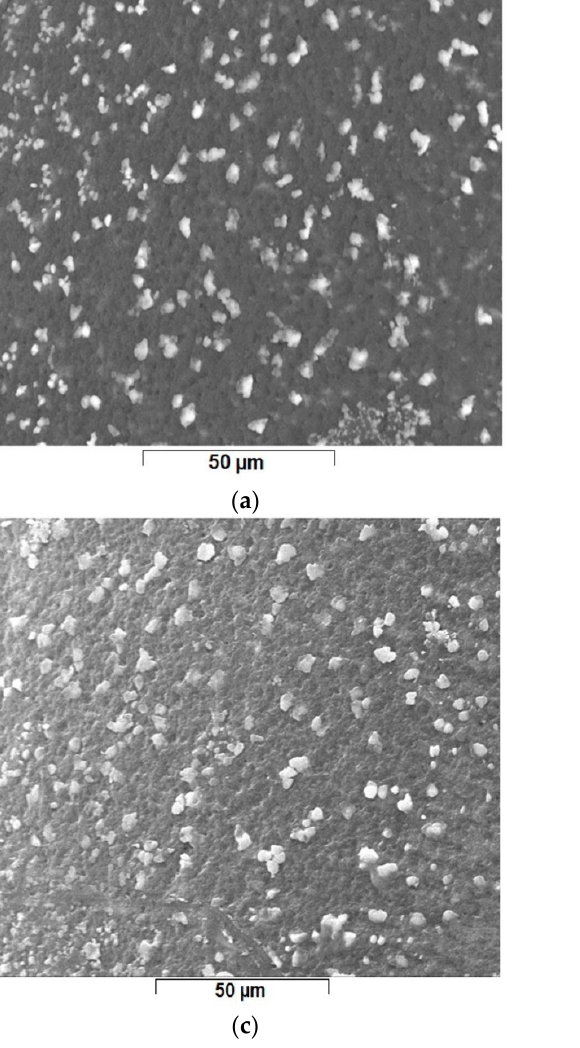
Figure 7. The scanning electron microscopy of the membrane support in the pores of which nanoparticle aggregates of metallic osmium have developed: raw osmium nanoparticles-polypropylene hollow fibers composite membrane 1 (Os-PP1) ( a ) ×2000 and ( b ) ×5000; and raw osmium nanoparticles-polypropylene hollow fibers composite membrane 2 (Os-PP2) ( c ) ×2000 and ( d ) ×5000.